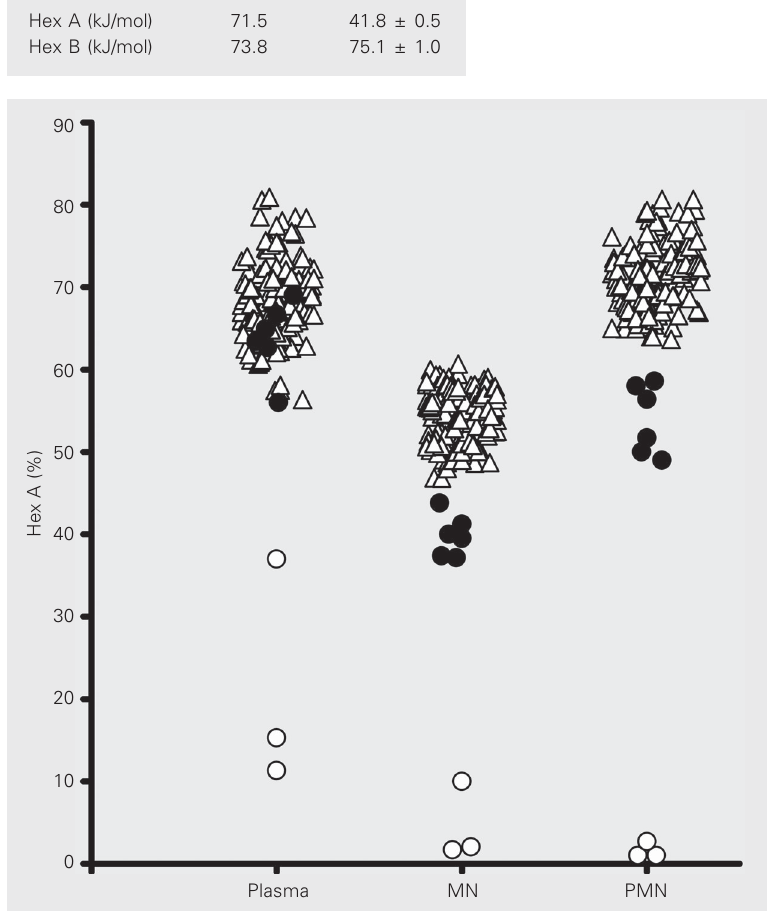
Figure 1. Relative proportions of Hex A isoenzyme in plasma and lysates of mononuclear (MN) and polymorphonuclear (PMN) leukocytes in controls (triangles), and in homozygous (open circles) and heterozygous carriers (filled circles) of the GM2-gangliosidosis B1 variant. The isoenzyme profiles were determined using the apparent enzyme activation